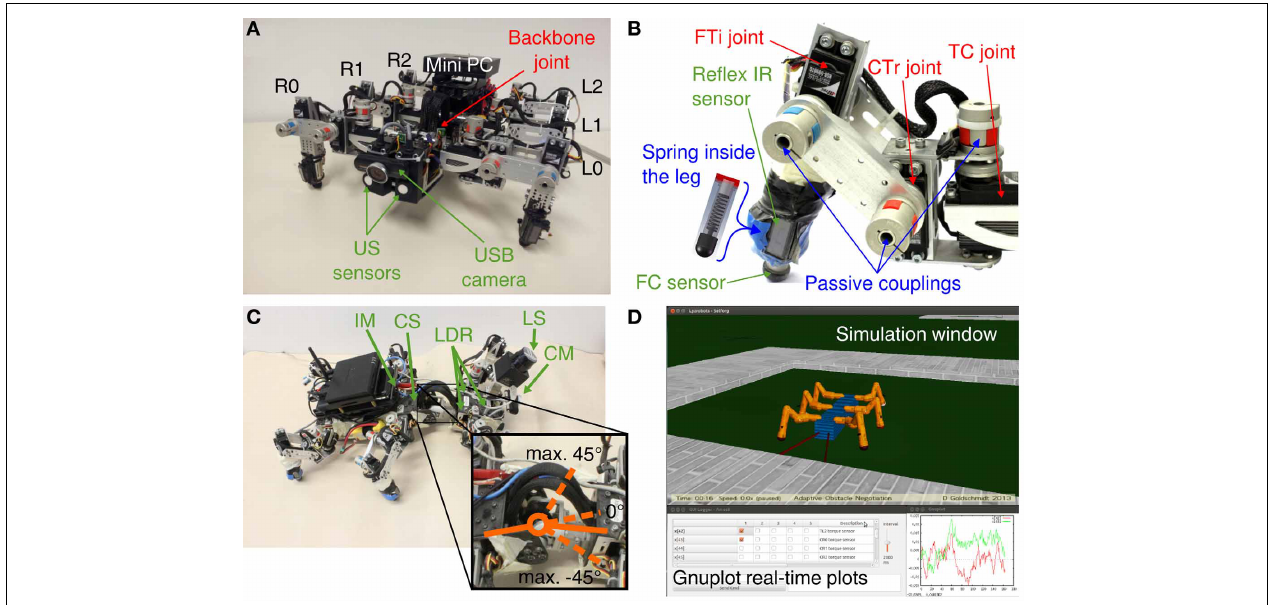
FIGURE 1 | Biologically-inspired hexapod robot AMOS II. (A) Sensors and leg configuration of AMOS II (front view). (B) Motor, sensor and passive component configuration of an AMOS II leg (R0). (C) Example of flexion and maximum range of the backbone joint